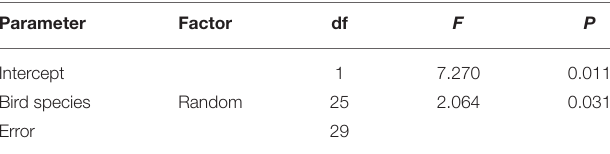
Fixed factors not included in the best model were the functional group and five size and shape morphological traits (body mass, beak length:wing chord ratio, beak width:wing chord ratio, beak length:beak height ratio, Kipp’s index).